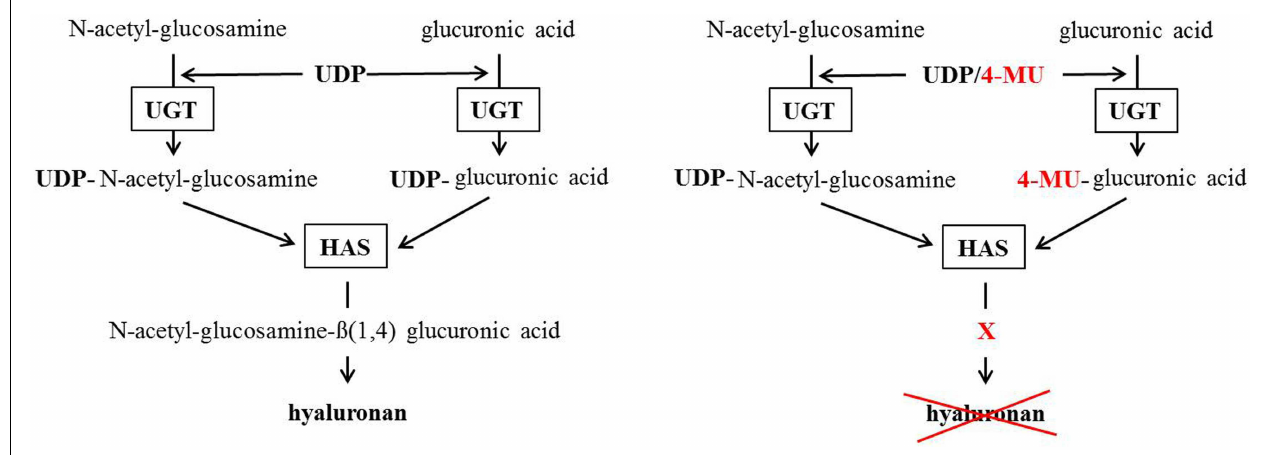
FIGURE 2 | Postulated 4-methylumbelliferone mechanism of HA synthesis inhibition .The left scheme shows the normal way HA gets synthesized.The right scheme shows how 4-MU binds to glucuronic acid instead of UDP so the HA-synthases (HAS) cannot build